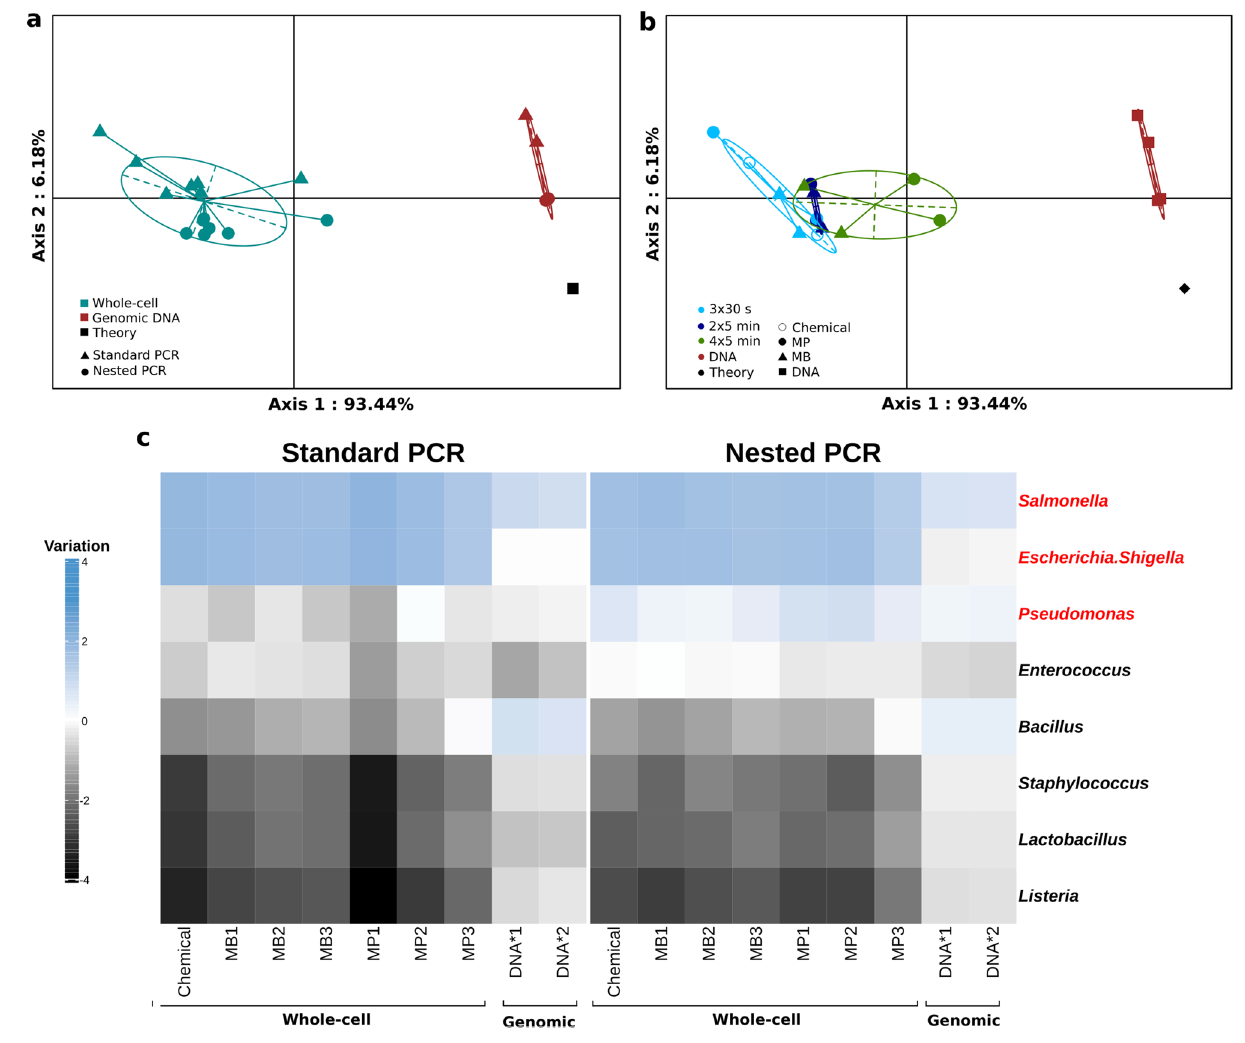
Figure 4. Extended mechanical lysing improves representation of gram-positive bacteria. ( a ) PCoA of whole- cell (cyan) and genomic DNA (brown) samples compared to the theoretical abundance profile (black). ( b ) The same PCoA was subjected to stratification of whole cell standards according to extraction protocol (mechanical lysing and DNA isolation). ( c ) Heatmap of variation from the theoretical abundance for all microbial community standards (columns) amplified by Standard (left panel) or Nested (right panel) PCR. The 8 bacterial taxa of the mock microbial community standard were ordered according to Gram-status; gram-negative (red) and gram-positive (black). Variation from theoretical abundance is calculated as log10[sample abundance/ theoretical abundance] for each genus. Figures were generated using R 39